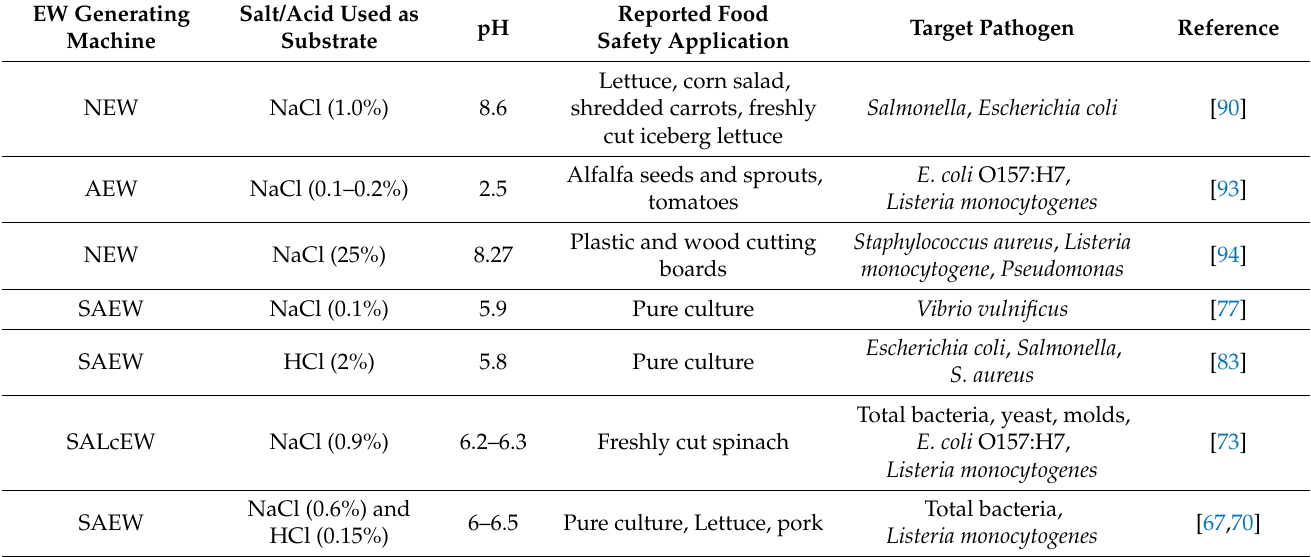
Table 2. Food safety applications of different types of electrolyzed